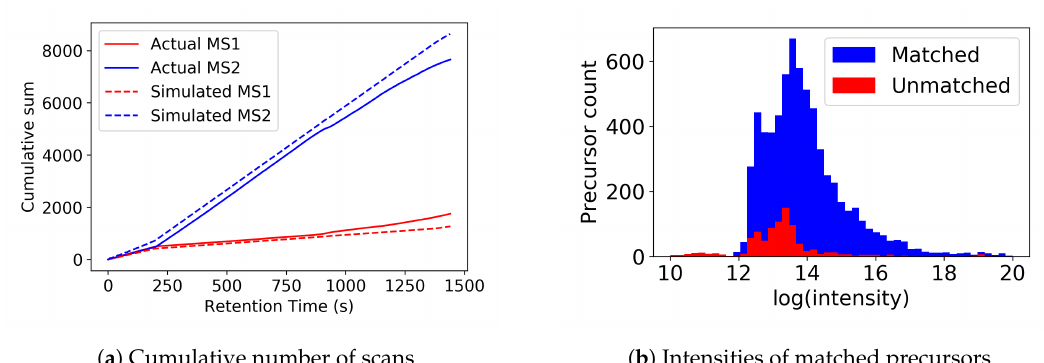
Figure 3. Figures showing ( a ) the cumulative number of MS1 and MS2 scans over time for real and simulated data, and ( b ) matched precursors from the actual multi-beer-1 data to the simulated data. Most precursors that could be matched (blue) have higher intensities than those that cannot be matched